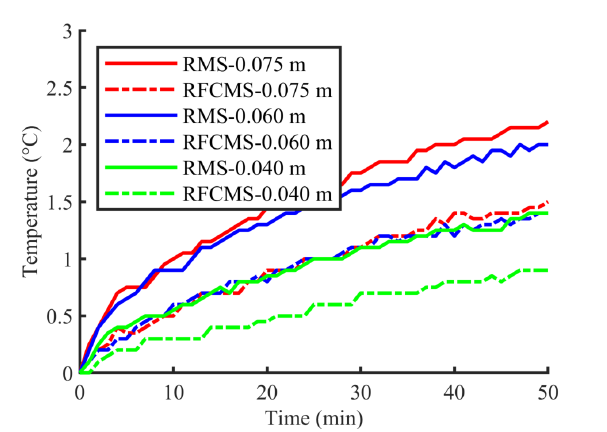
Figure 9. Temperature change curve of LRG for different